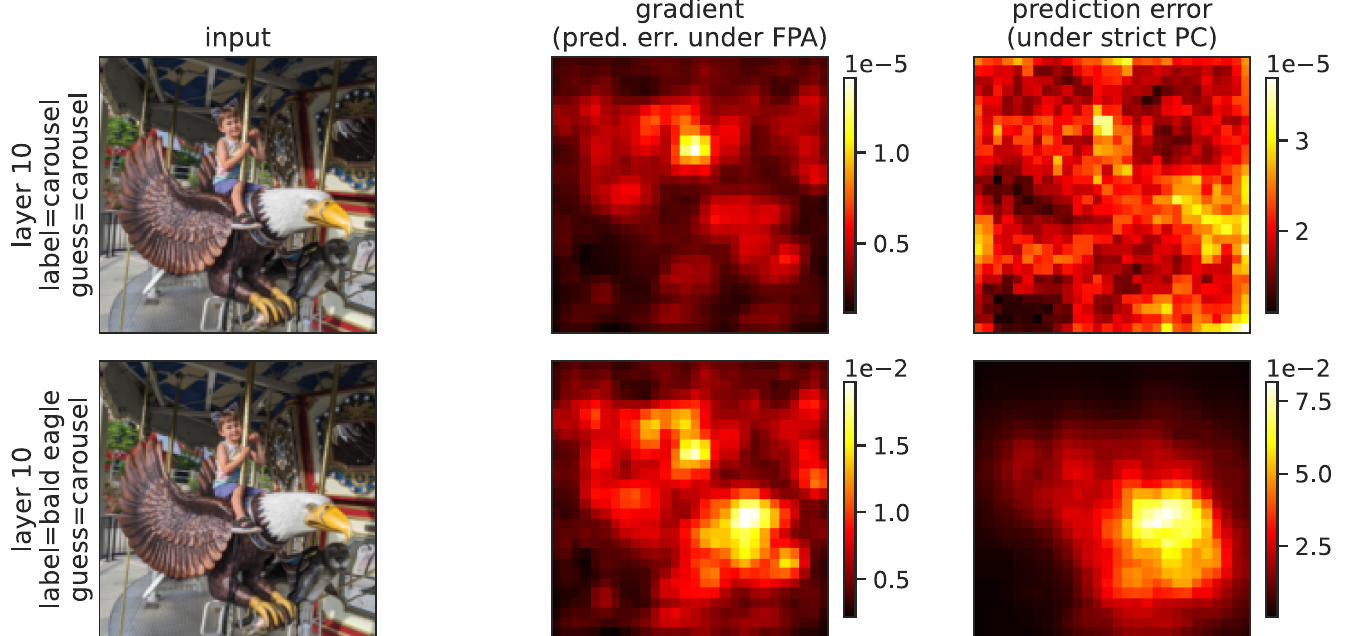
Fig 9. Magnitude of activations, beliefs, and prediction errors in response to matched and mismatched inputs and labels. Same as Fig 8, but for the bottom row the label did not match the network’s guess.